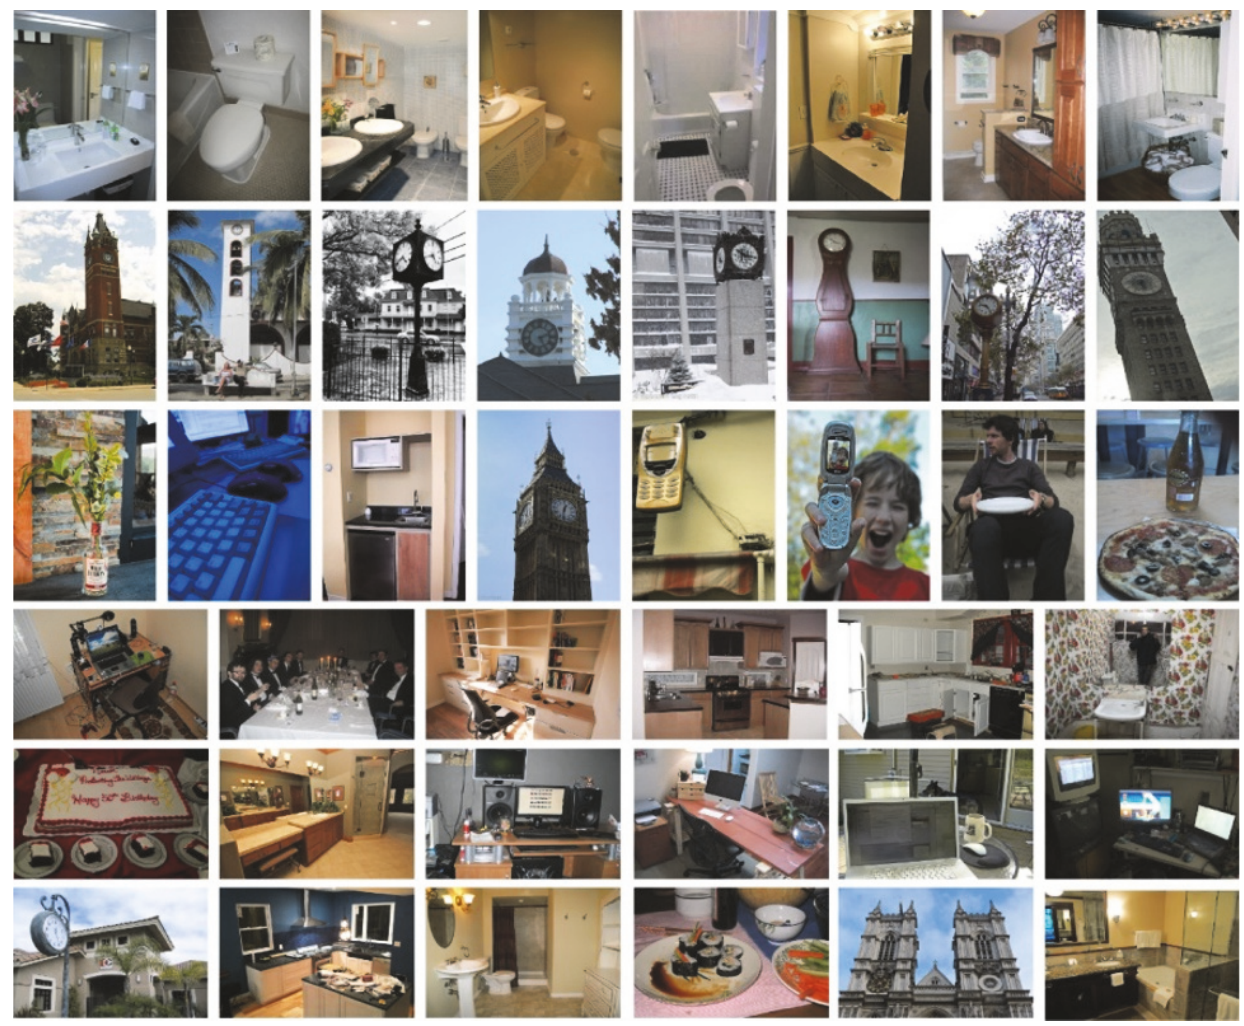
Figure 1: Small object